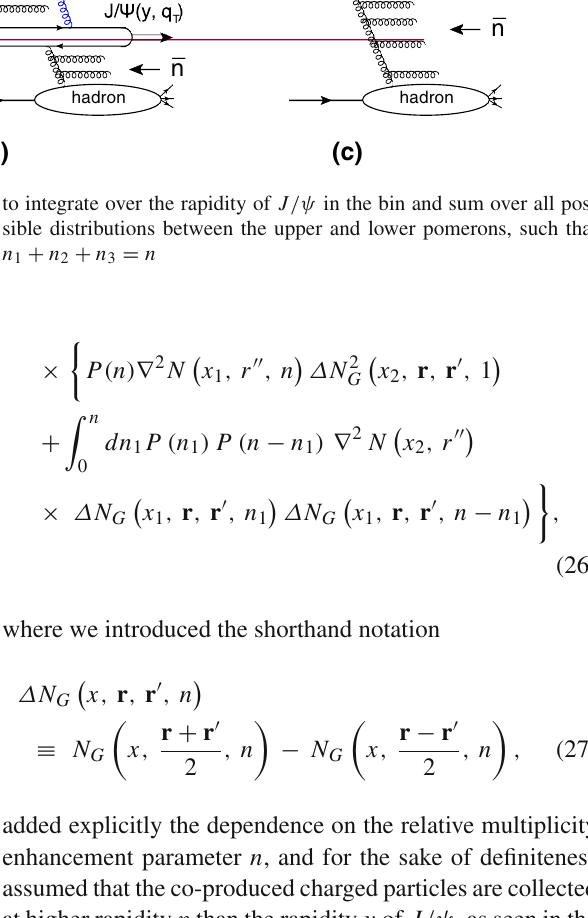
Fig. 4 Contribution of different configurations to the observed mul- tiplicity of charged particles, when quarkonium ( J /ψ ) and charged particle bins are well-separated by rapidity. We can clearly attribute